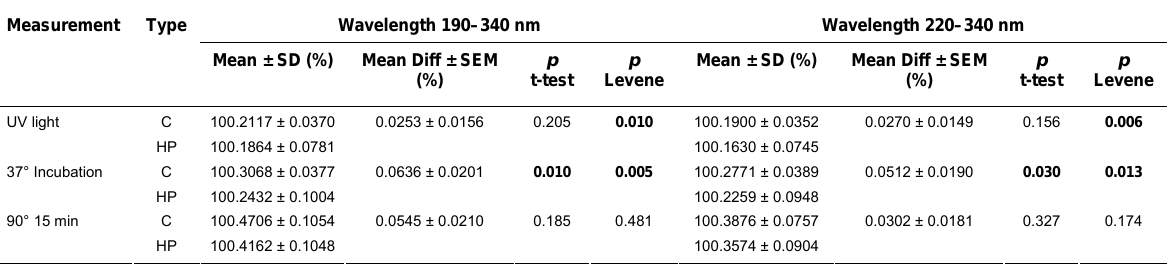
Results of the Different Measurements of CuSO Homeopathic Preparations and Controls that 4 were Exposed to External Factors*